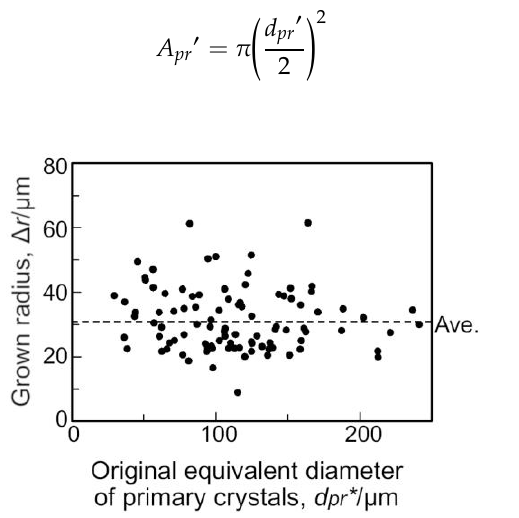
Figure 10. “Grown radius” Δ r , which is the increment of radius during cooling, for each original equivalent diameter of primary crystal, d pr * . The dotted horizontal line indicates the average grown length ∆ r .